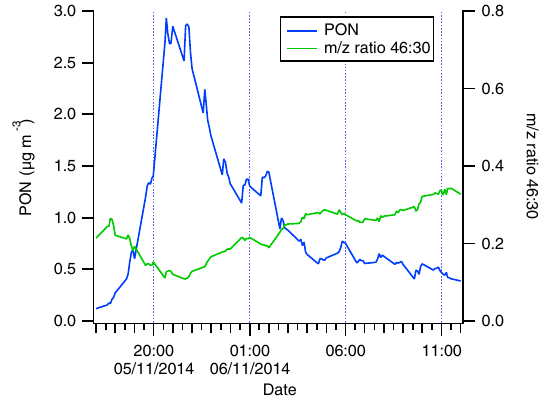
Figure 4. PON concentrations during Bonfire